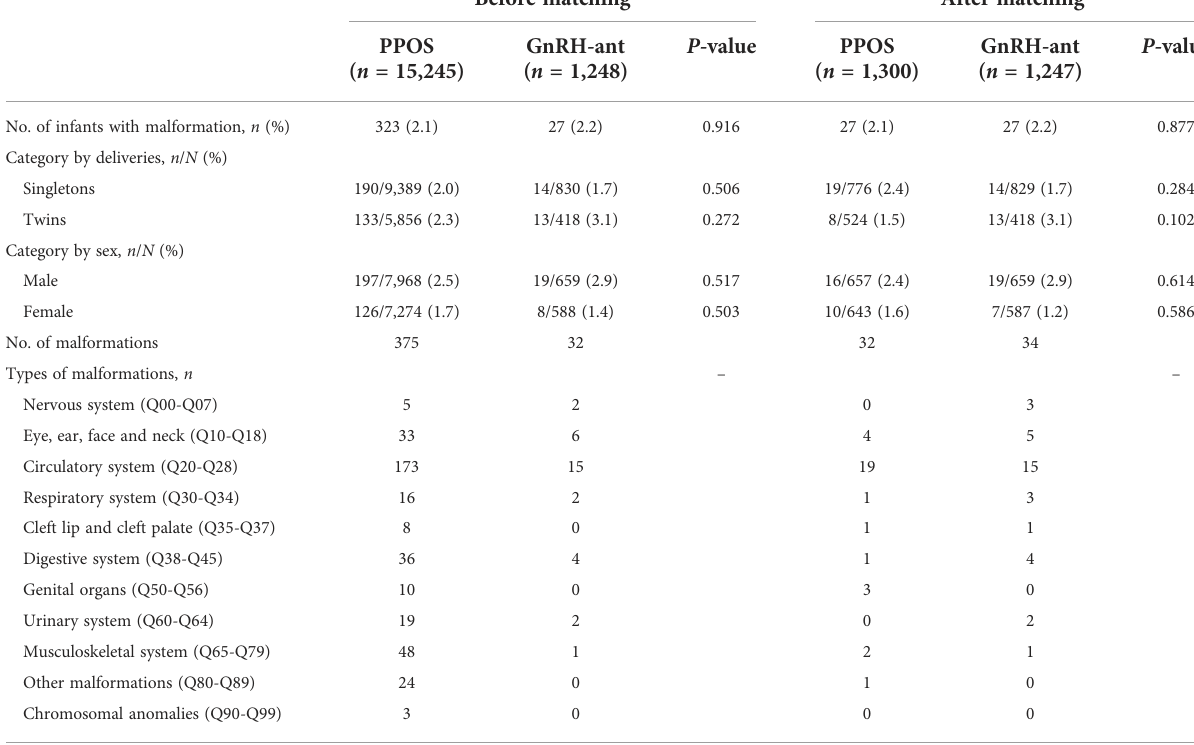
TABLE 3 Congenital malformations of live-born infants between the PPOS and GnRH-ant groups. Before matching After matching